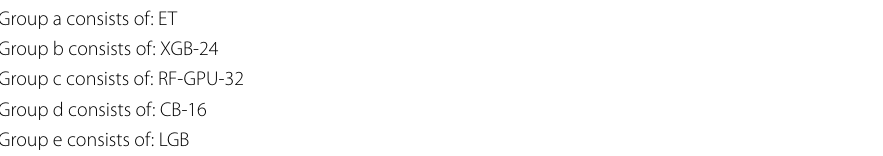
Table 24 HSD test groupings after ANOVA of AUPRC for the CLF factor